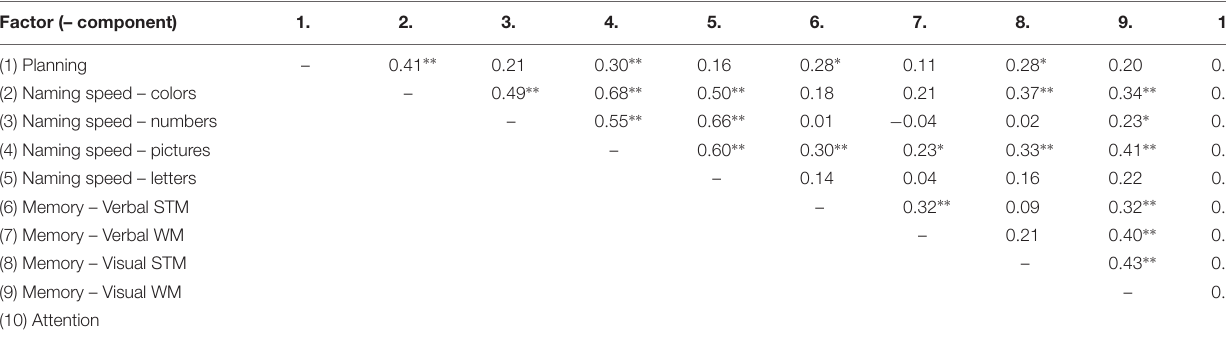
TABLE 3 | Correlations between all factors and component.